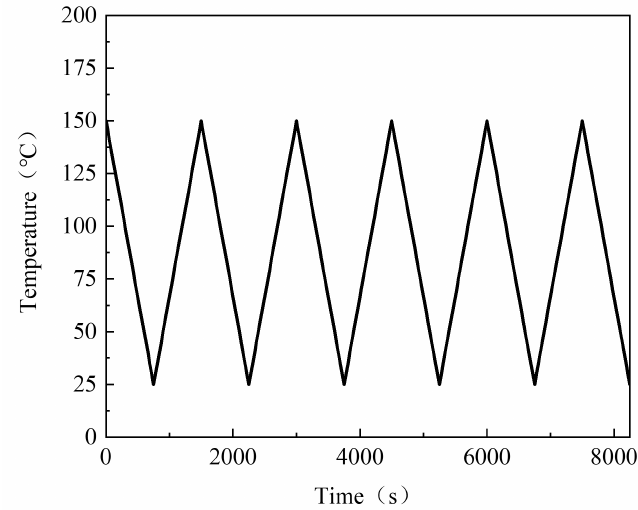
Figure 2. Temperature cycle profiles used in the